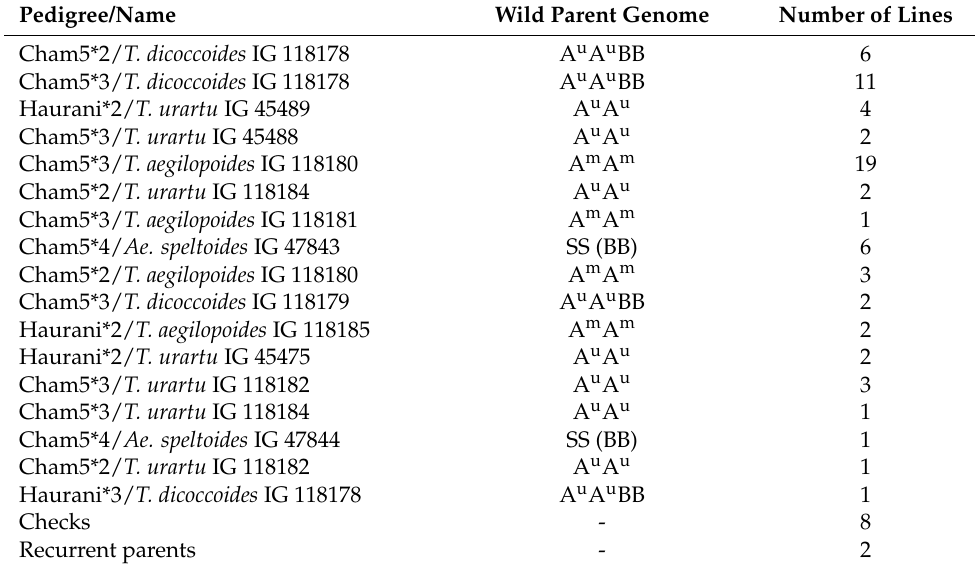
Table 1. Pedigree and number of derivative lines from each